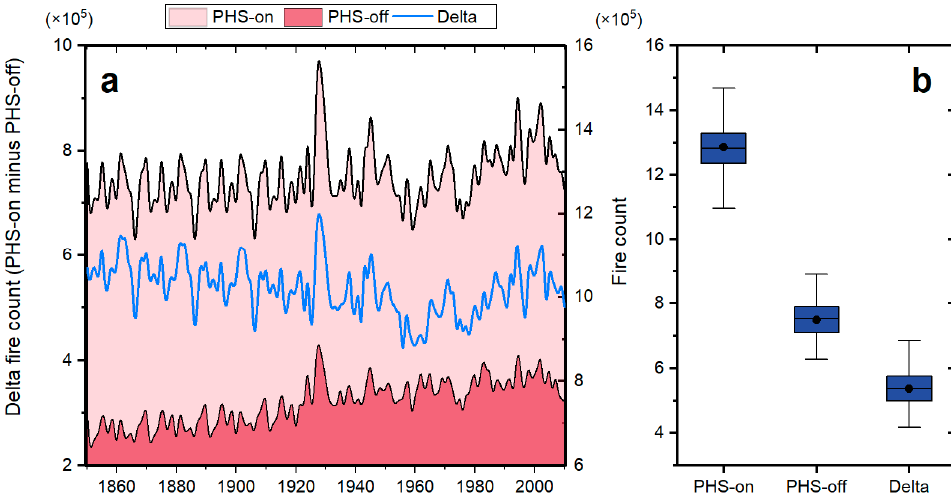
Figure 5. Annual global fire count during 1850–2010 from CLM5 simulations without (PHS-off) and with PHS (PHS-on) configurations and their difference (Delta). The fluctuations of annual global fire count during 1850–2010 were shown in ( a ). Boxes in ( b ) represent the interquartile ranges of the annual global fire count distributions, solid lines (circles) in the boxes represent median (averaged) values, and whiskers extend to one interquartile range.